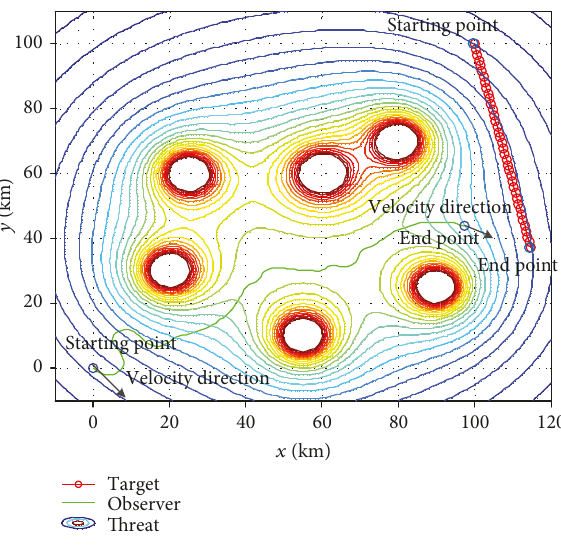
Figure 6: moving target tracking in scenario 4.